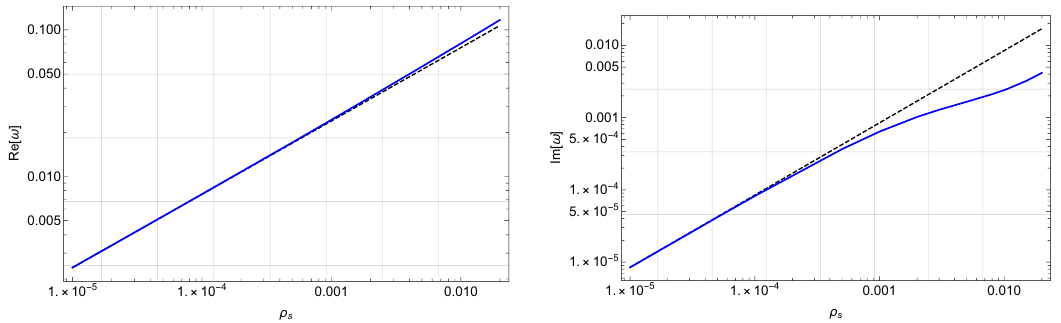
. The ( s ) } = { 0 . 015 , 1 , − 3 / 2 , 1 } ( s )